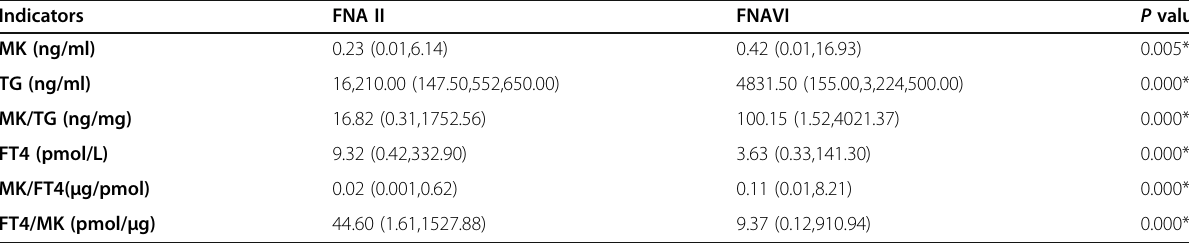
Table 5 The expression levels of MK ratios in FNA categories II and VI Indicators